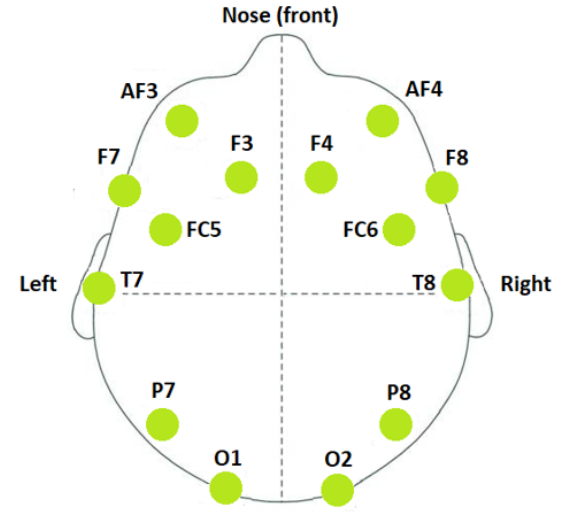
Figure 1. Electrode